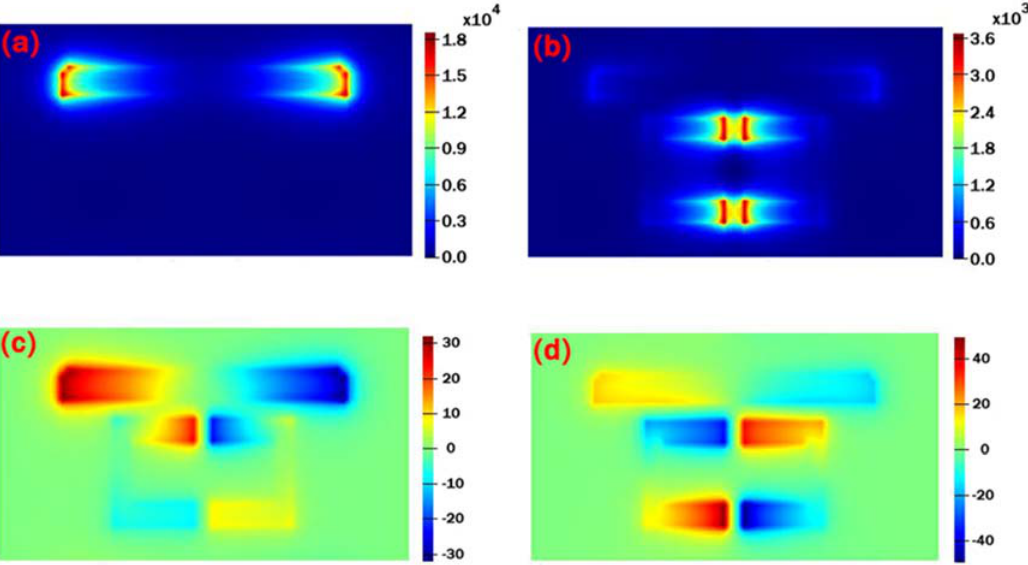
Figure 3. The simulated electric field of | E z | 2 -component of ( a ) the individual graphene CW resonator at 5.95 µ m and ( b ) the PIT metasurface with CW resonator and SRRs at 6.08 µ m. The E z field distribution of the PIT metasurface with graphene CW resonator and SRRs at ( c ) 5.93 µ m and ( d ) 6.26 µ m.